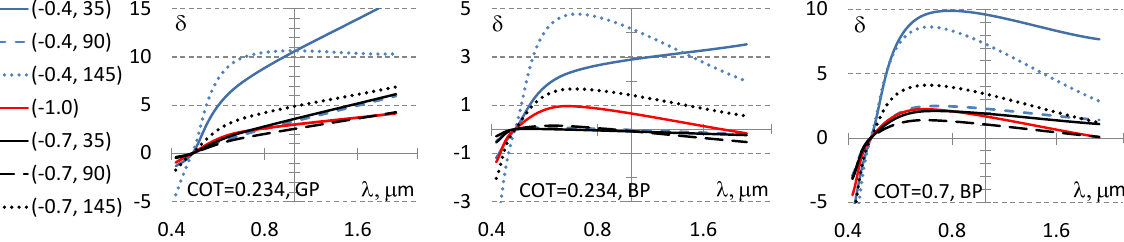
Fig. 1. Spectral residuals ( δ λ ) from aerosol retrieval for a cloudy pixel with optical thickness of 0.234 (a–b) and 0.7 (c) at MODIS wavelengths 0.412, 0.47, 0.67 and 2.13µm. The results are shown for two surface types representing dense vegetation ( (a) , GP) and an urban (city) area ( (b–c) , BP). The red, black and blue lines correspond to cosines of view zenith angle µ = − 1, − 0.7 and − 0.4, and the solid, dashed and dotted lines represent relative azimuths of 35 ◦ , 90 ◦ , and 145 ◦ ,